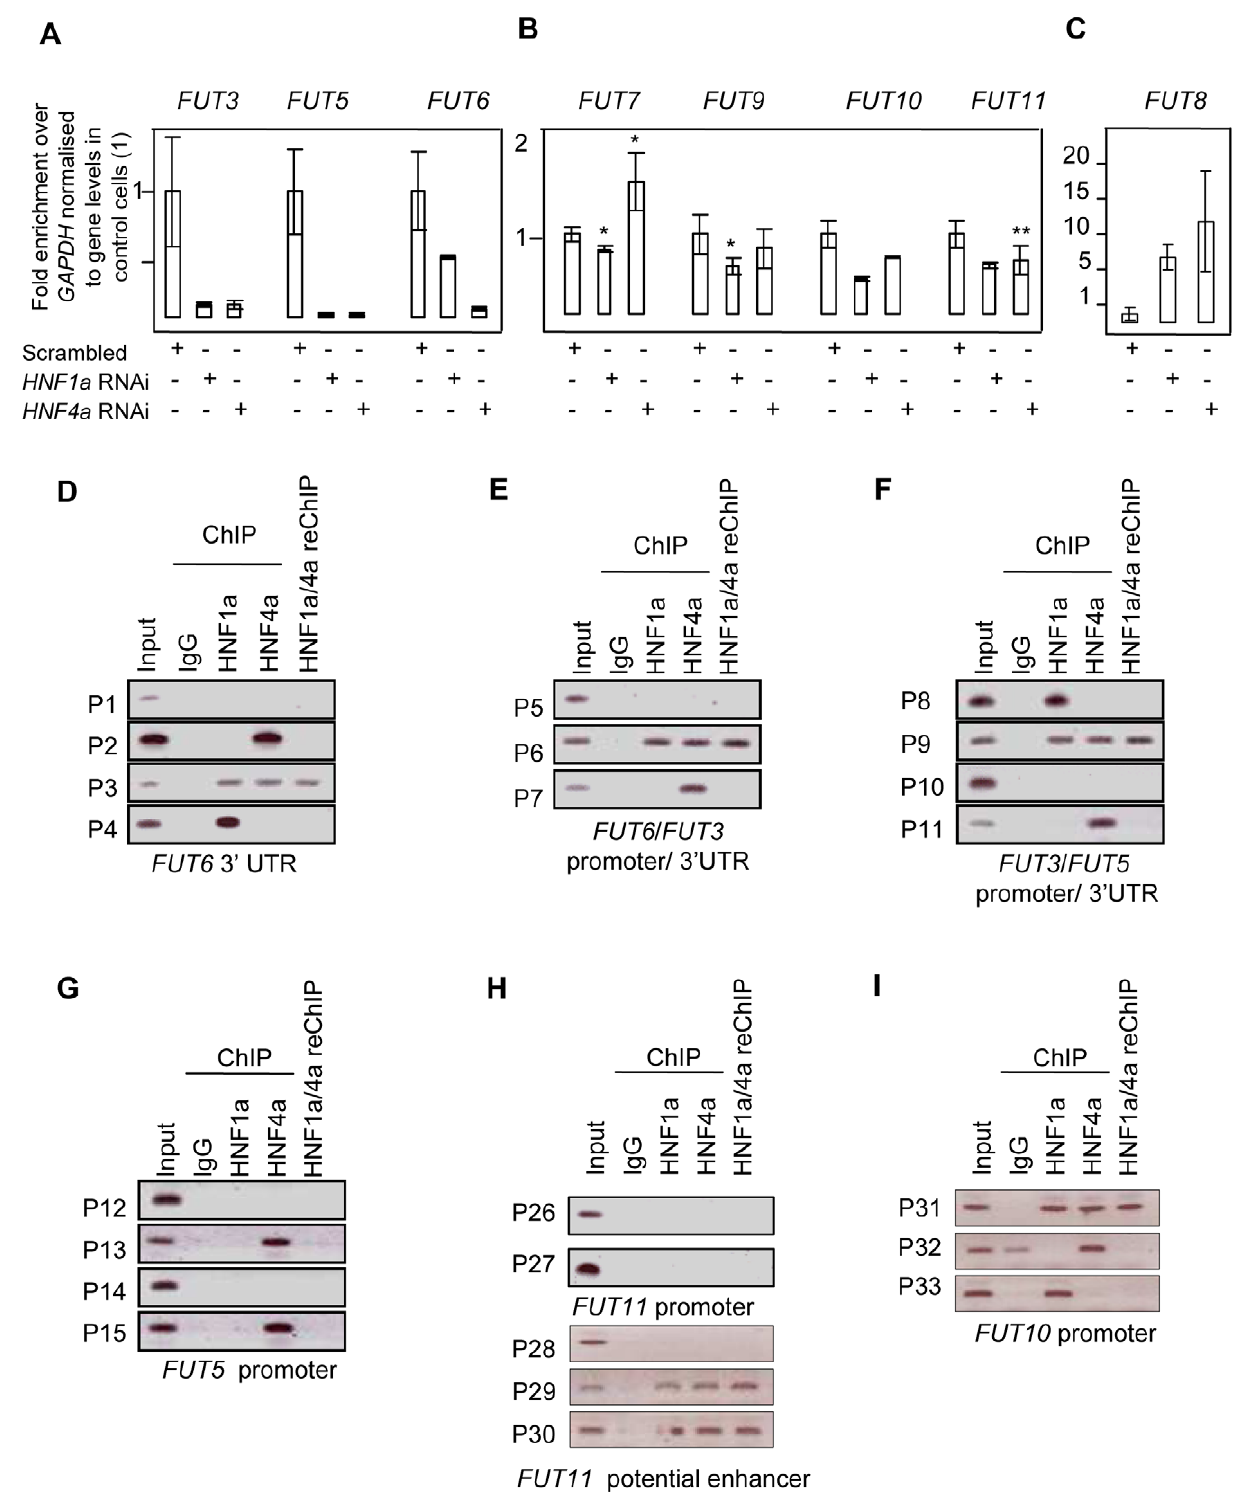
Figure 4. HNF1 a is major regulator of the fucosyltransferase genes. Real time PCR for FUT3 , FUT5 and FUT6 RNAs (A); FUT7 , FUT9 , FUT10 and FUT11 (B); FUT8 (C) after HNF1 a and HNF4 a RNA interference (RNAi) in HepG2 cells. H) analyses show that Hnf1 a (HNF1) and Hnf4 a (HNF4) bind predicted regulatory elements for key fucosylation genes in liver cells. D), E), F), G), H) and I) Binding of HNF1 a and HNF4 a to predicted regulatory elements of the FUT3 , FUT5, FUT6, FUT10 and FUT11. Abbreviations: the gene names are detailed in Figure 1; P1–P37: Primer sets 1 to 37; 3 9 UTR: 3 9 un- translated region. reChIP: re-precipitation (or sequential) ChIP.